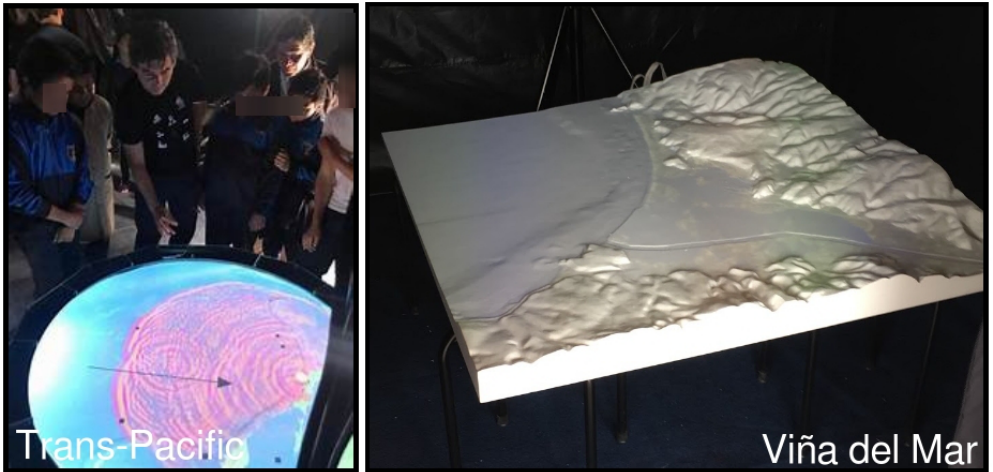
Figure 4. TsunamiLab simulation (left panel) and projection mapping of the tsunami inundation model on the Viña del Mar scaled relief mock-up, where numerical simulations are projected (right